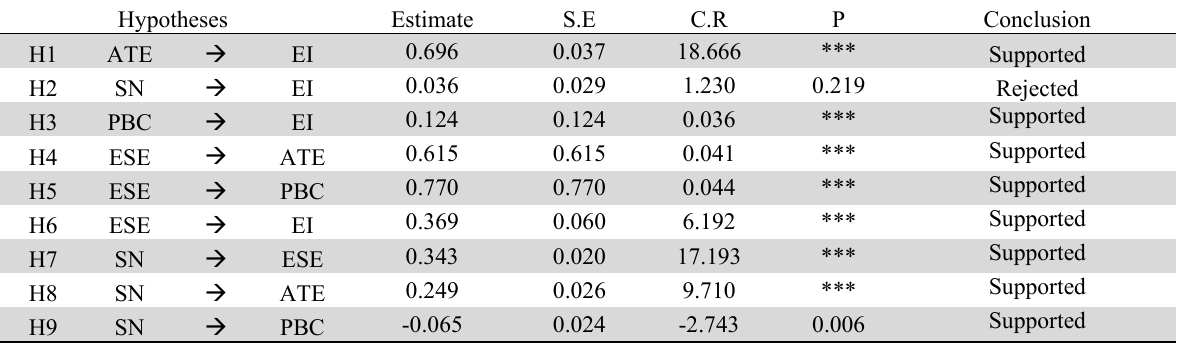
The results of testing the research hypotheses